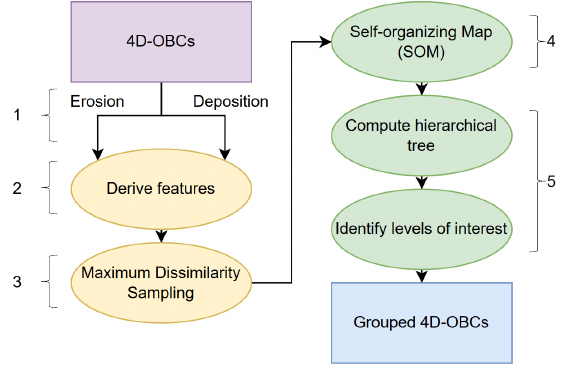
Figure 3. Workflow with the five main steps to obtain grouped 4D-OBCs based on their